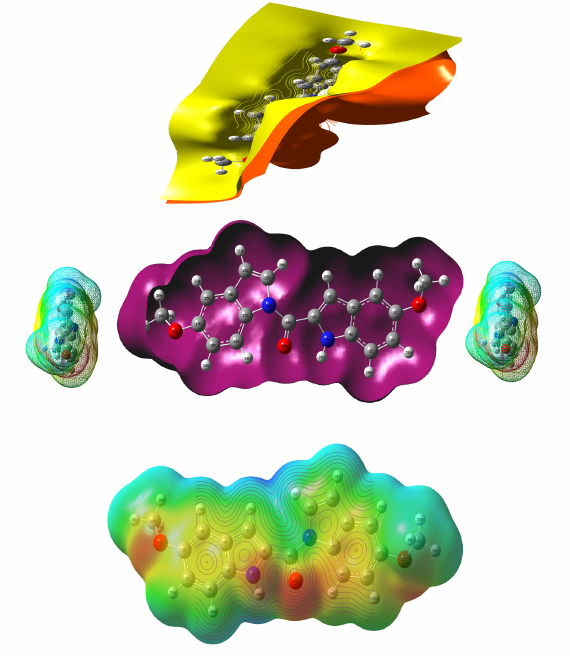
Figure 5 : Molecular electrostatic potential (MEP) map and electron density (ED) of MIMIM.